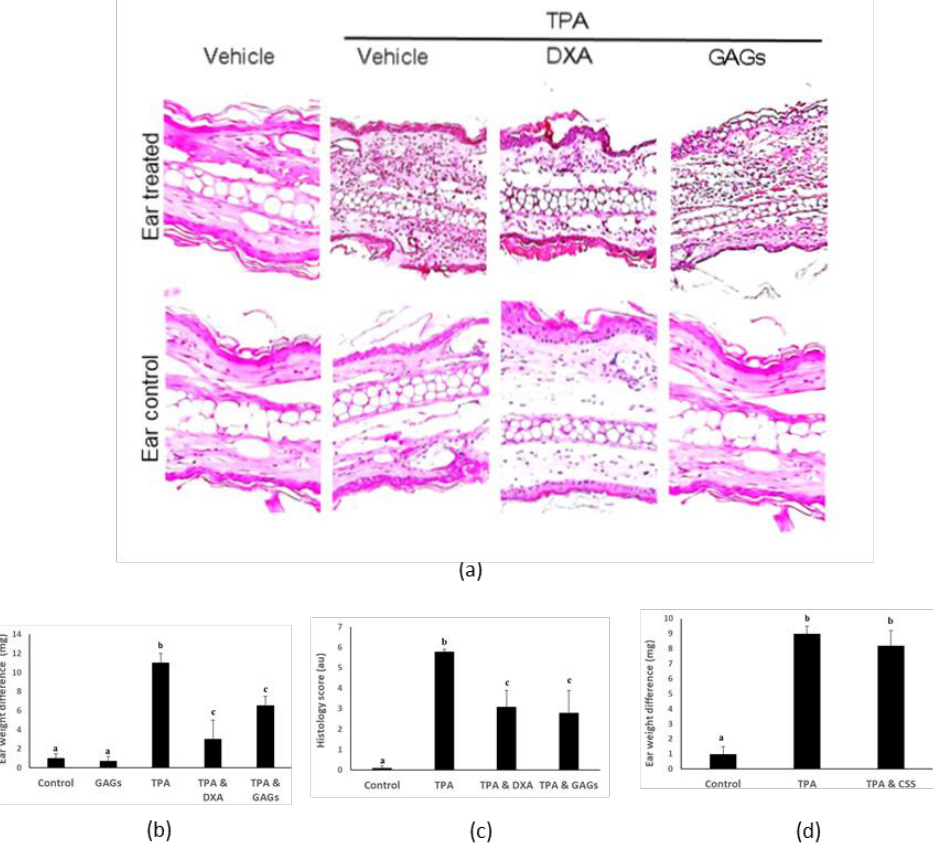
Figure 3. GAGs from sea cucumber ( I. badionotus ) body wall exert anti-inflammatory effects in a mouse ear inflammation model. Mouse ears exposed to vehicle (control, left ear), or inflammatory agent TPA alone, or TPA followed by dexamethasone (DXA) or GAGs (right ear). ( a ) Representative photomicrographs of transverse section of mouse ears sensitized with TPA or TPA and test substance, stained with haematoxylin-eosin (magnification 10X). Images are representative of five mice with similar results. ( b ) Differences in ear weights (right – left) after treatment with TPA or TPA and test substance; n ≥ 5 per group. ( c ) Histological score for ear micrographs in ( a ); values are the mean ± SEM, n = 3 per group. ( d ) Differences in ear weights (right – left) after treatment with TPA or TPA and shark cartilage (CSS); n ≥ 3 per group. Values with distinct superscripts differ significantly from each other ( p ≤ 0.05).